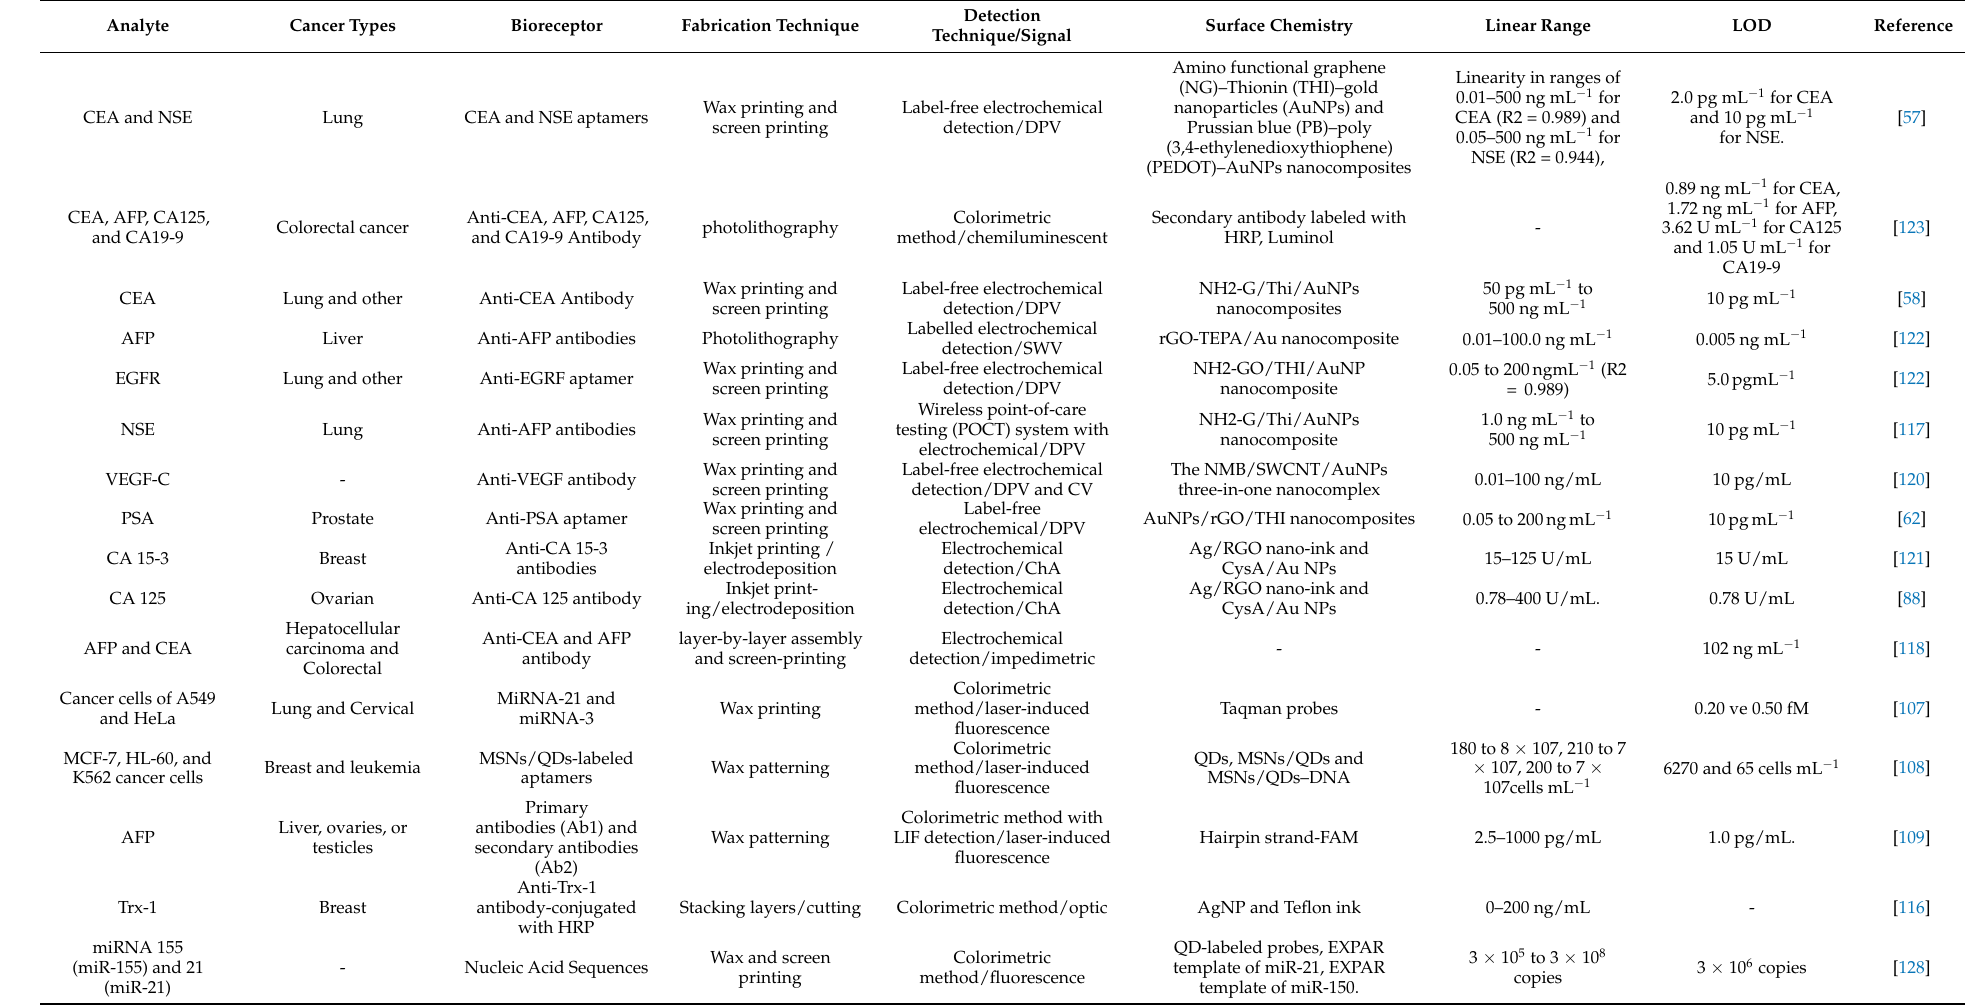
Table 2. Summary of microfluidic paper-based biosensor applications in the detection of cancer biomarkers using various analysis methods in the